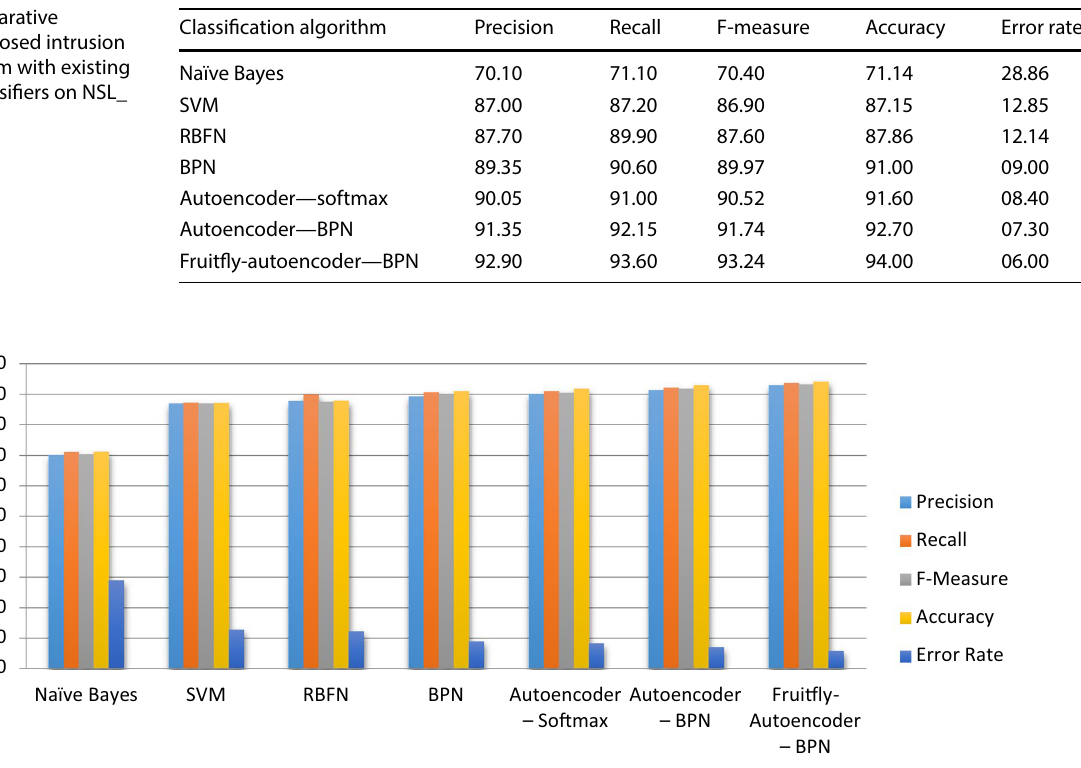
Fig. 6 Relative quantitative measures for intrusion detection system on NSL_KDD dataset